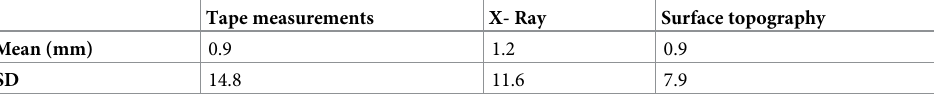
Table 2. Comparison of different measurement methods assessing LLIs or pelvic obliquity in ninety-nine patients after receiving a THA at our